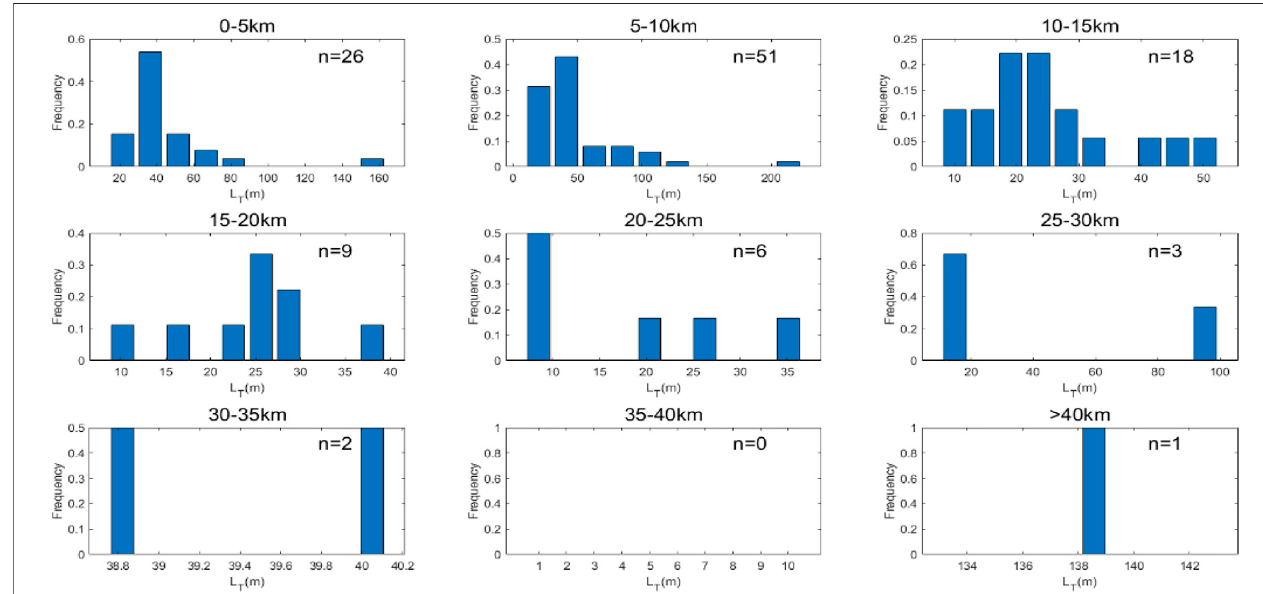
FIGURE 6 | Histogram of Thorpe scale frequency distribution per 5 km height for seven sets of sounding data from January 10 to